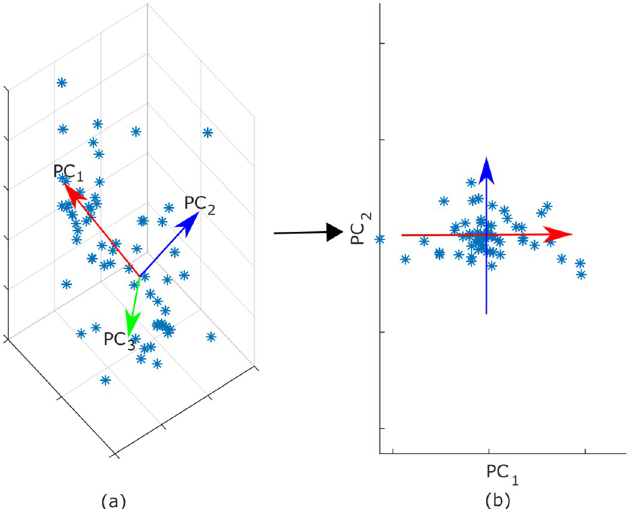
Fig 1. Dimensionality reduction process performed with a PCA: (a) Data distribution in a three-dimensional input space and the corresponding principal components; (b) Projection of the data into the two-dimensional space with the PC 1 , PC 2